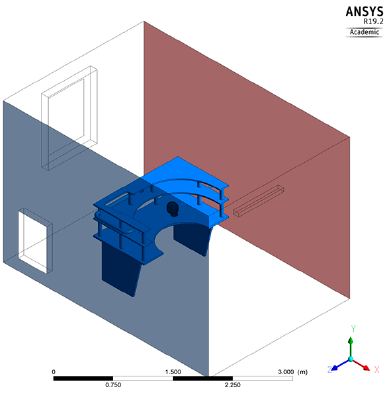
Figure 4. Room Figure 4. Room geometry. Figure 4. Room geometry.